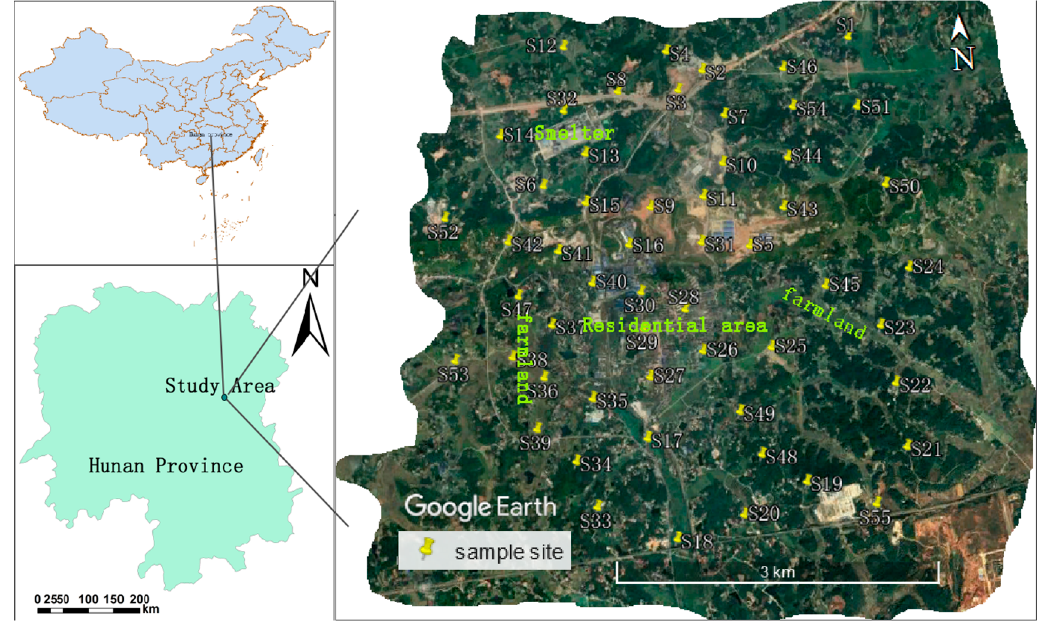
Figure 1. Distribution of sampling points in the study area.